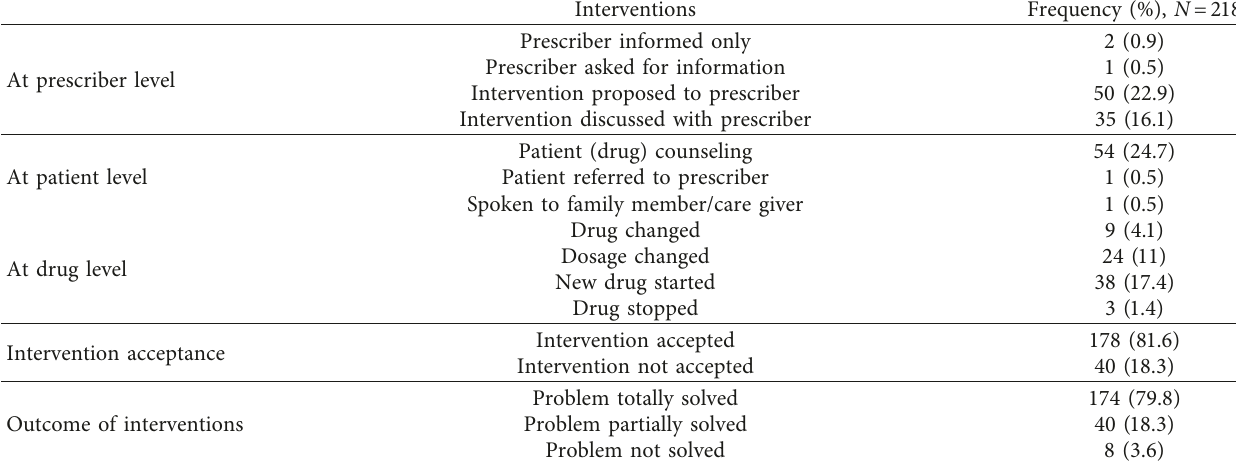
Table 5: Interventions and outcomes of interventions of MRPs among study participants at JUMC, Jimma Zone, Jimma, Southwest Ethiopia, from April 1 to September 30,